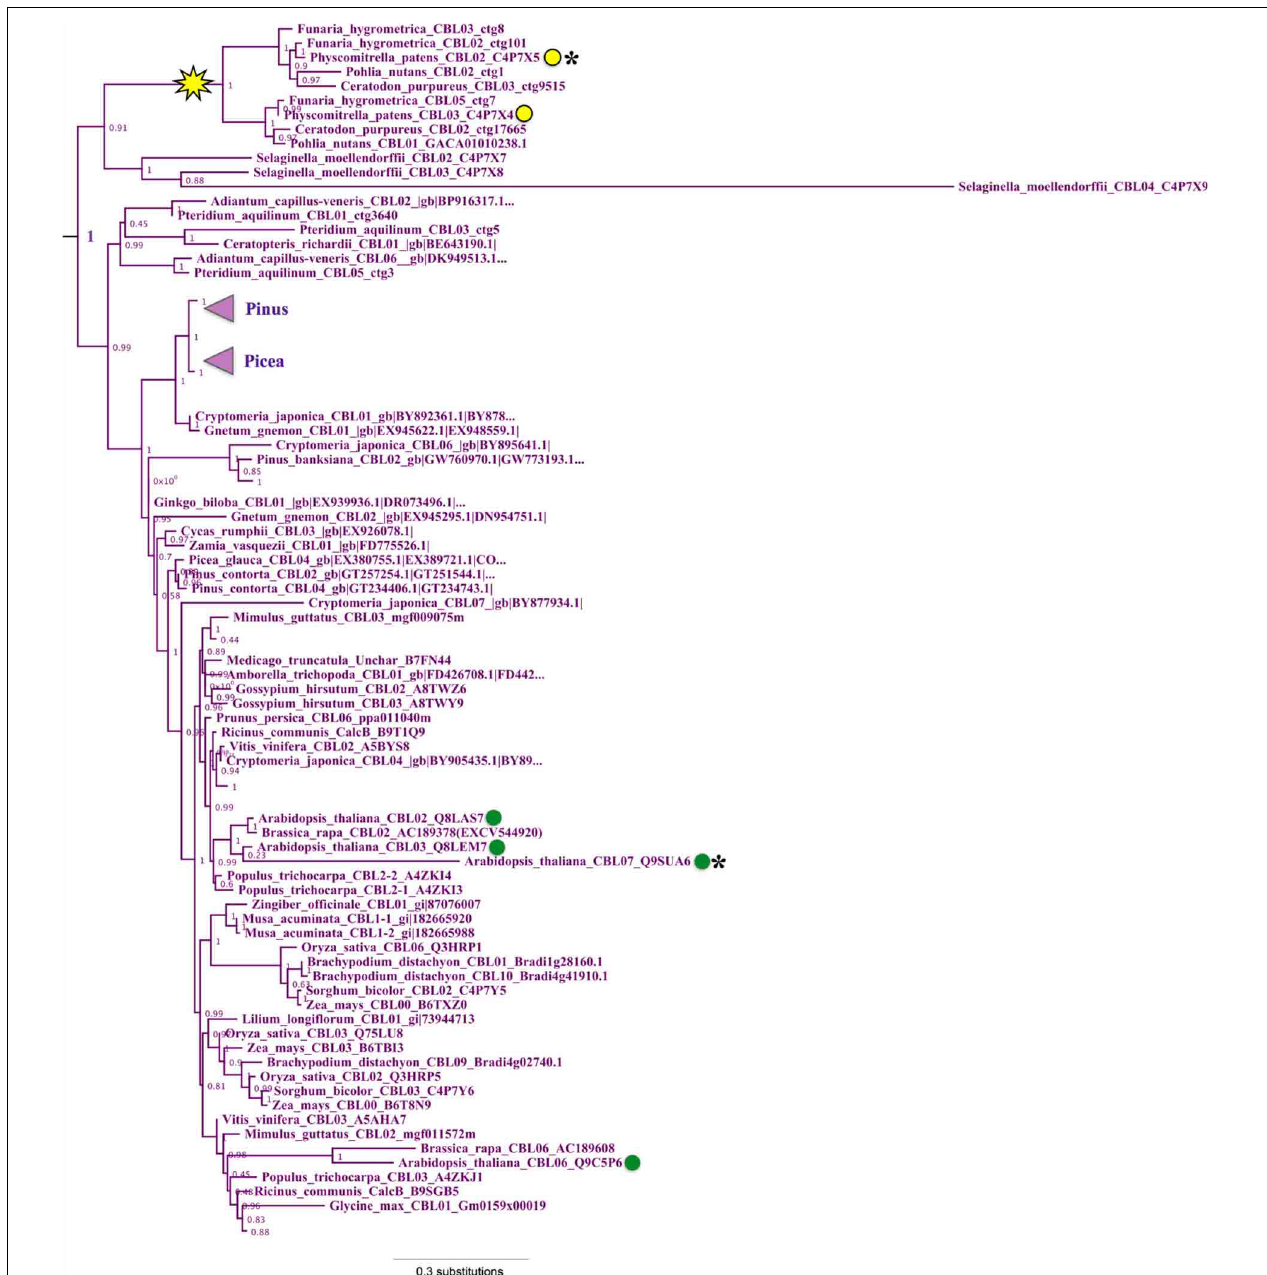
FIGURE 4 | Close-up of Type II CBL clade from ML tree shown in Figure 2. Confidence scores (aLRT) are shown for each clade, and the yellow star denotes an inferred intron loss event. Some clades are unlabeled or collapsed for clarity (see full tree in Supplementary File S2). Type II CBLs are distinguished by the presence of an N-terminal tonoplast targeting sequence (TTS), however certain members (asterisks) of the Type II clade have lost or